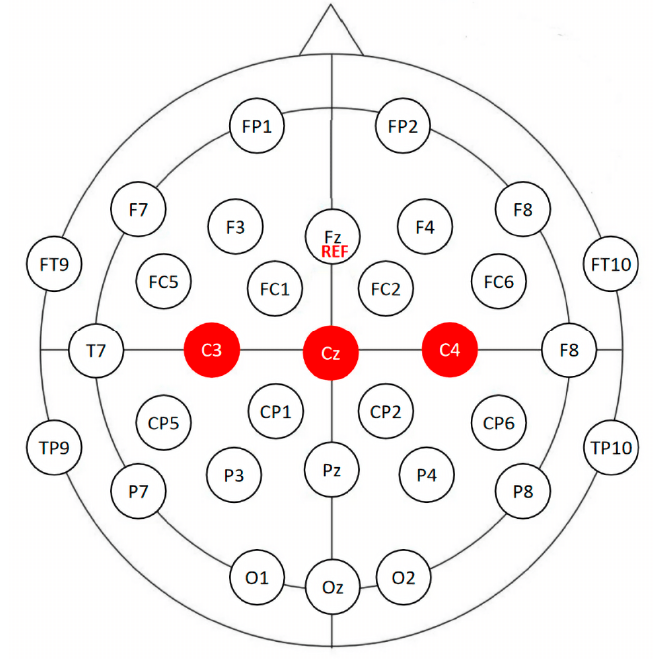
Figure 4. The 32-channel EEG recording montage used in our experiments. Channels C3, C4, and Cz are in the mid-central area, marked as red circles. REF denotes that Fz is the reference electrode.